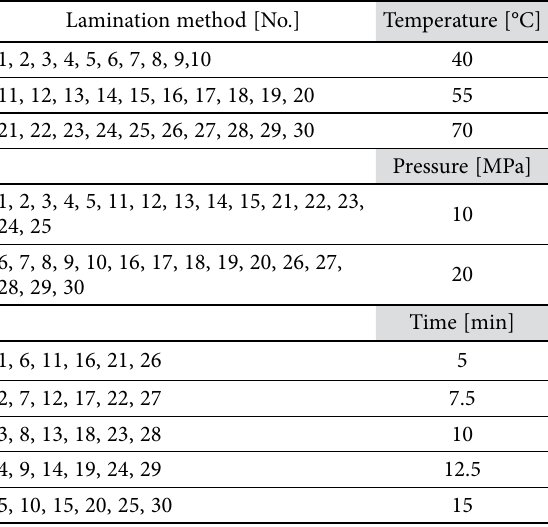
Table 1. The optimal lamination parameters* Lamination method [No.] Temperature [°C]